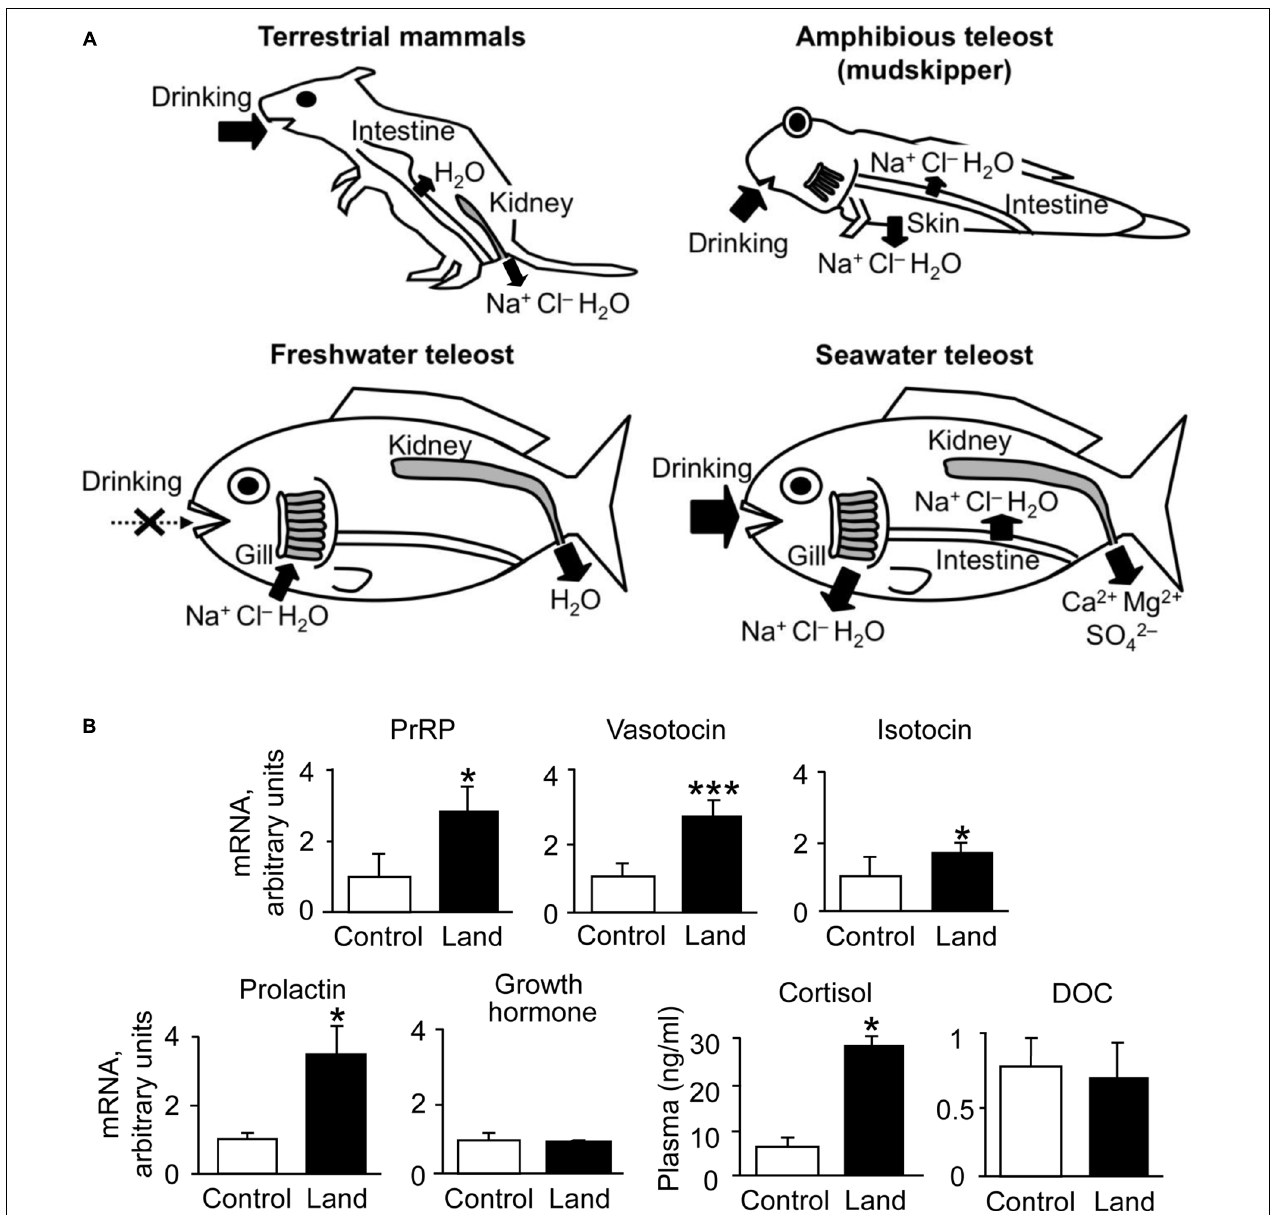
FIGURE 1 | Environmental adaptations in vertebrates. (A) Osmoregulatory mechanisms in mammals and teleosts. Arrows show active and passive transport of ions and/or water. The osmoregulatory mechanisms are flexible in euryhaline species such as catadromous eels and anadromous salmonids, which switch ion and water regulation to opposite directions via active transport. In addition to aquatic teleosts, the amphibious and euryhaline mudskipper, which invades land in its lifecycle, is used for the study of osmoregulation. (B) Dynamics of osmoregulatory hormones in terrestrial adaptation of mudskippers. Cortisol and DOC are shown as plasma concentrations (Sakamoto et al., 2002, 2011), and the other hormones are shown as the expression of their genes in the brain of mudskippers in controls (in one-third seawater) or on land ( n = 4–8) (Sakamoto et al., 2005a, 2015). Data are shown as the means ± SE. ∗ p < 0.05, ∗∗∗ p < 0.001 with t -test or Mann–Whitney U -test. PrRP, prolactin-releasing peptide; DOC,